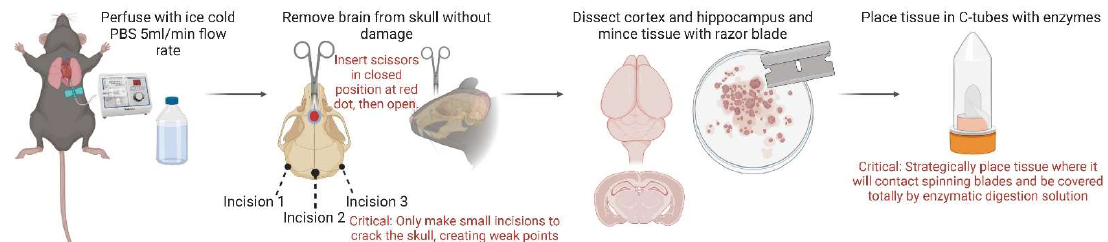
Figure 2. Schematic workflow of transcardiac perfusion, brain removal, dissection, and preparation of tissue for dissociation and enzymatic digestion. (Red denotes key steps that should be proceeded with carefully to ensure optimal performance, especially if dealing with small tissue quantity <50